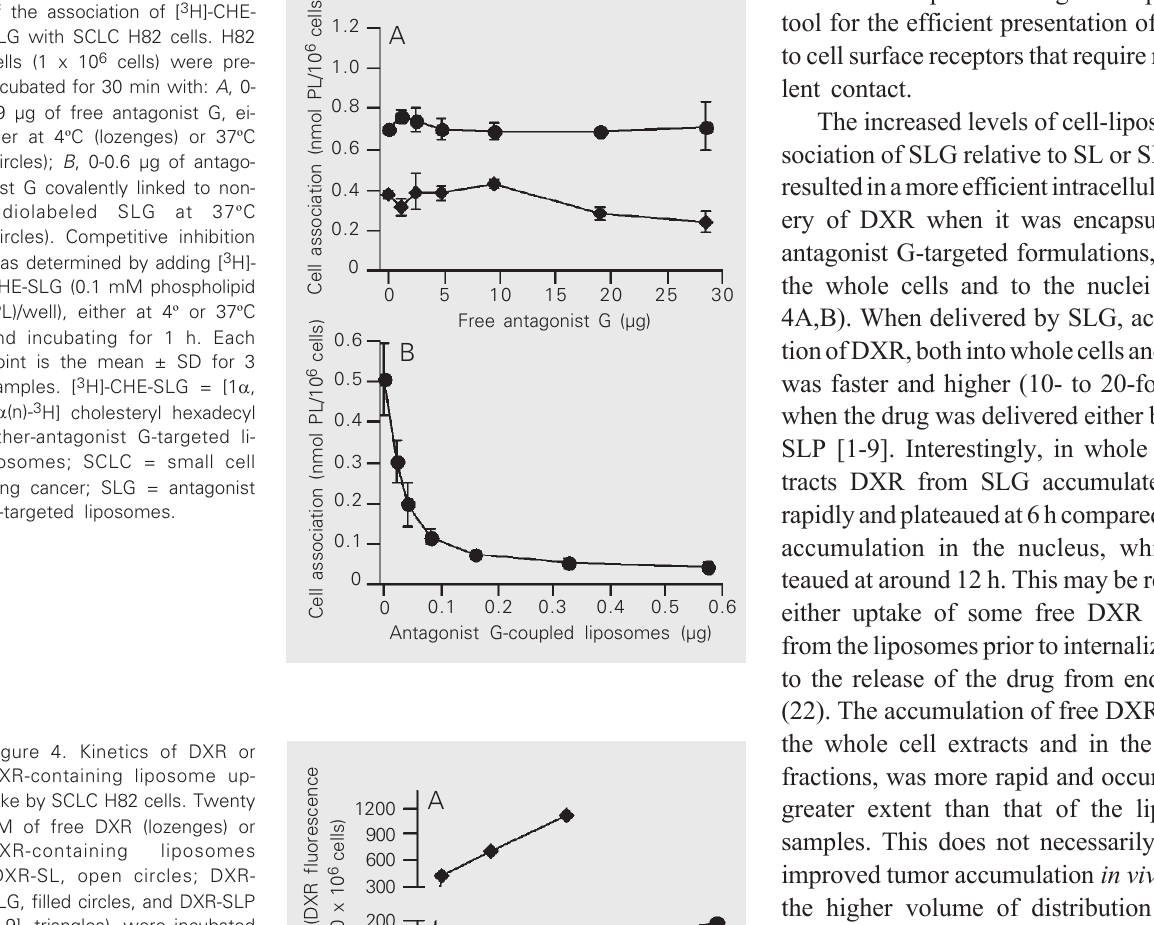
Figure 3. Competitive inhibition of the association of [ 3